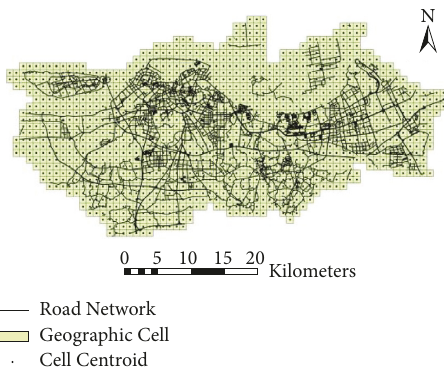
Figure 2: Geographic cell division.